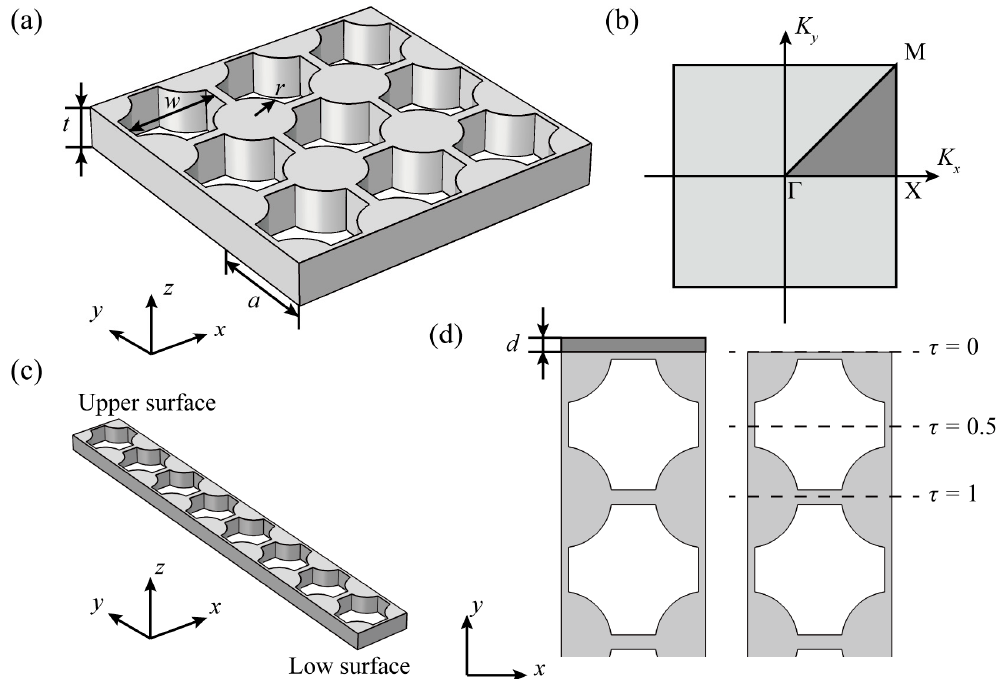
Figure 1. Diagram of the 2D phoxonic crystals (PXC) slab ( a ) and the corresponding Brillouin zone ( b ). The structural geometry is described by the lattice constant a , circle radius r , hole width w, and slab thickness t . Schematic sketch of the truncated PXC slab for the surface modes ( c ) and enlarged diagram of the upper surface region ( d ). Two surface parameters, i.e., the adding layer thickness d and termination parameter τ , are used to tune the surface